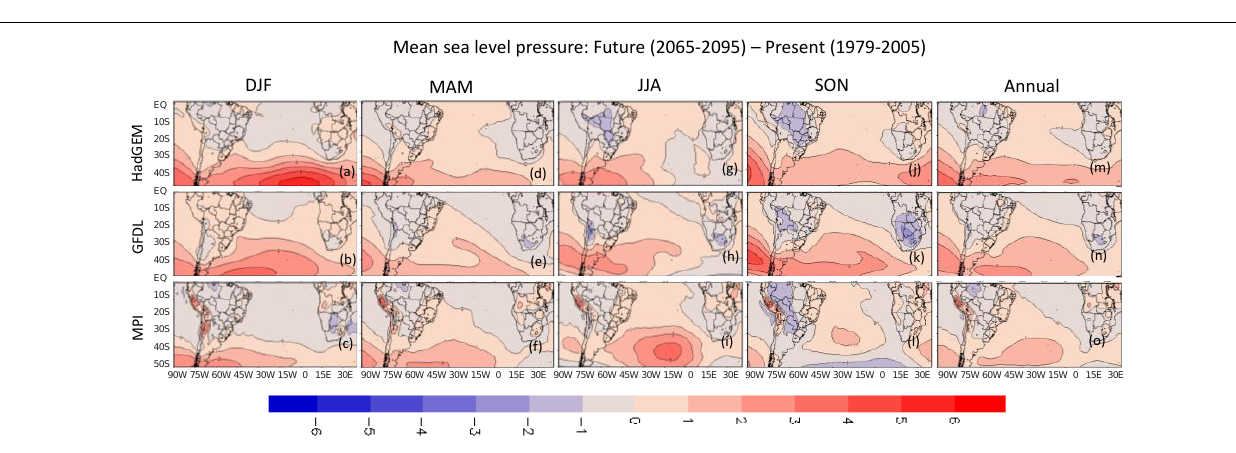
FIGURE 7 | Differences between the mean sea level pressure in the future (2065–2095) and present (1979–2005) climates, for seasonal and annual periods, from HadGEM (a,d,g,j,m) , GFDL (b,e,h,k,n) , and MPI (c,f,i,l,o) global climate